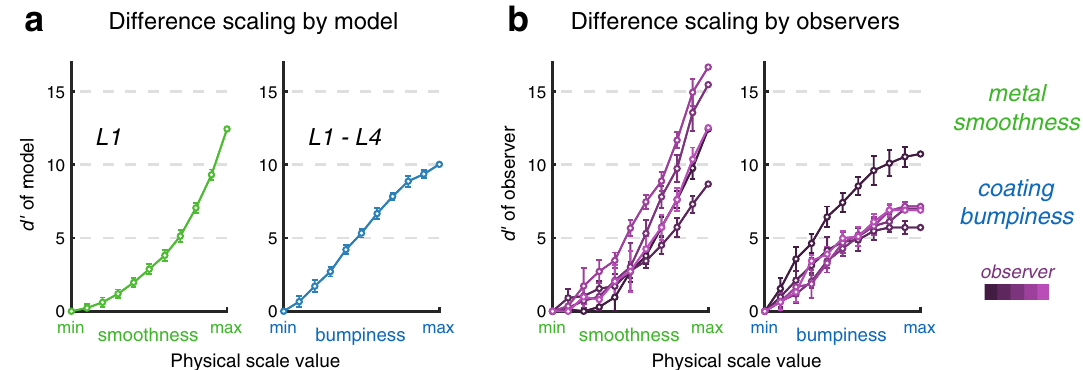
Figure 4. Comparison of computational models and observers for difference scaling of the dimensions of the stimulus space. ( a ) Simulated difference scaling using models of metal smoothness and coating bumpiness. The models use only the output of steerable pyramid levels for comparing trials. ( b ) Difference scaling results obtained from 5 observers completing an MLDS task. Error bars show 95% confidence intervals obtained via